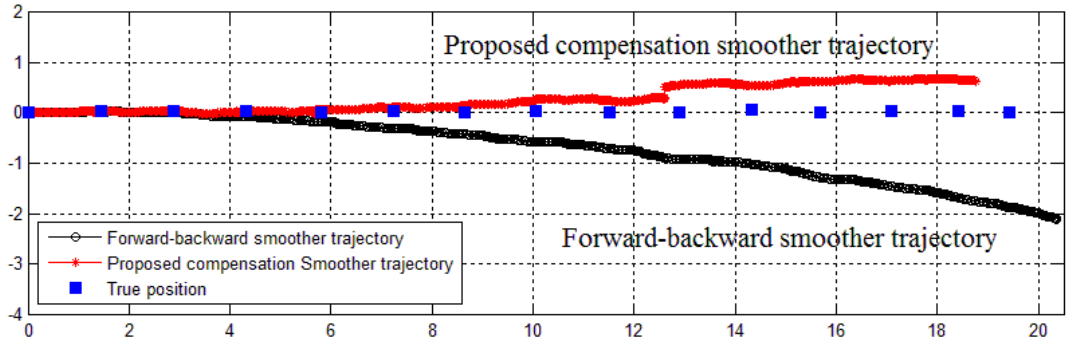
Figure 16. True and estimated trajectories of a walking